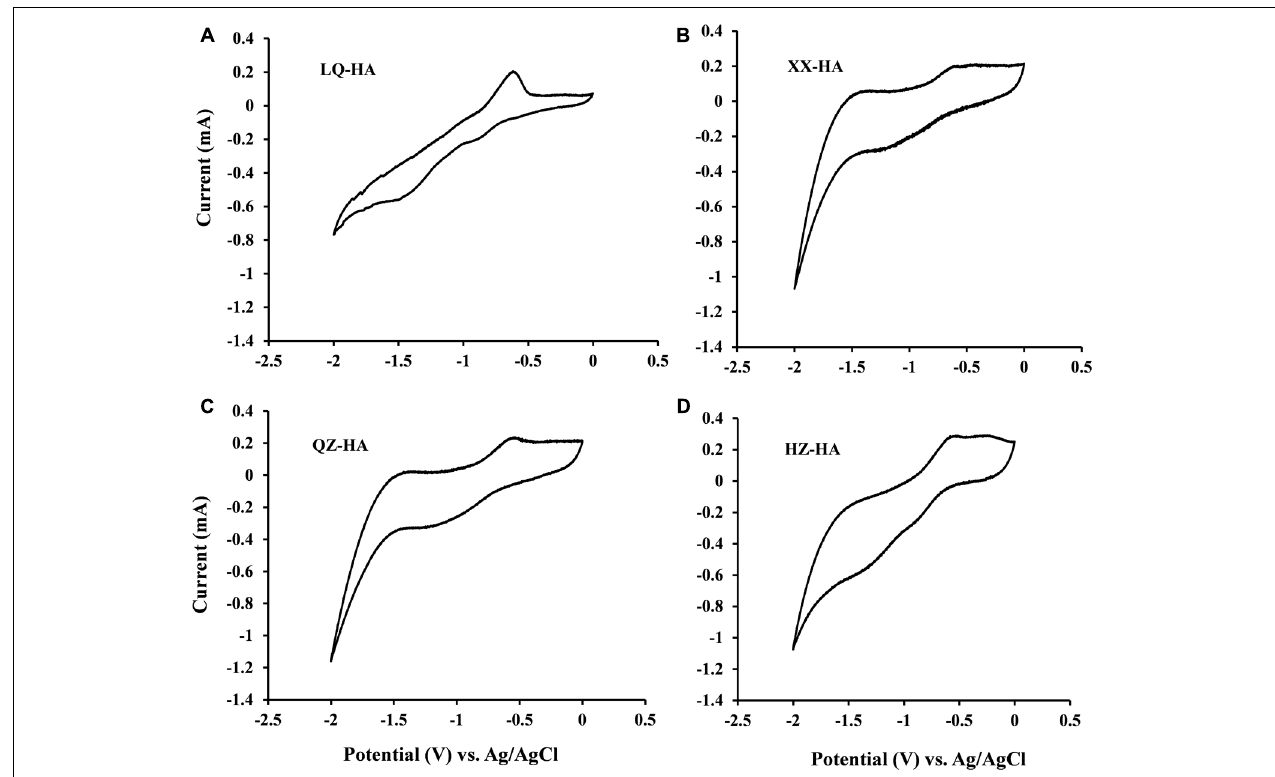
FIGURE 1 | Cyclic voltammograms of different HAs [LQ-HA (A) , XX-HA (B) , QZ-HA (C) , HZ-HA (D) ] dissolved in DMSO. Abbreviated names of HAs are the same as those presented in Table 1